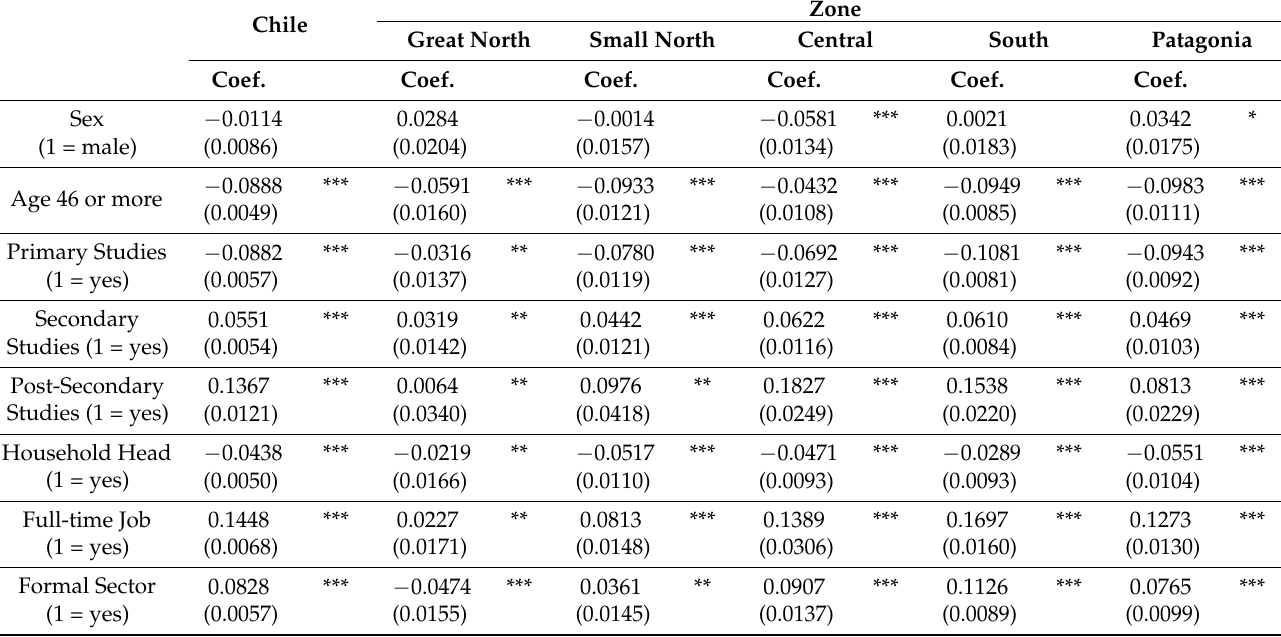
Table 6. Result data matching: Propensity Score